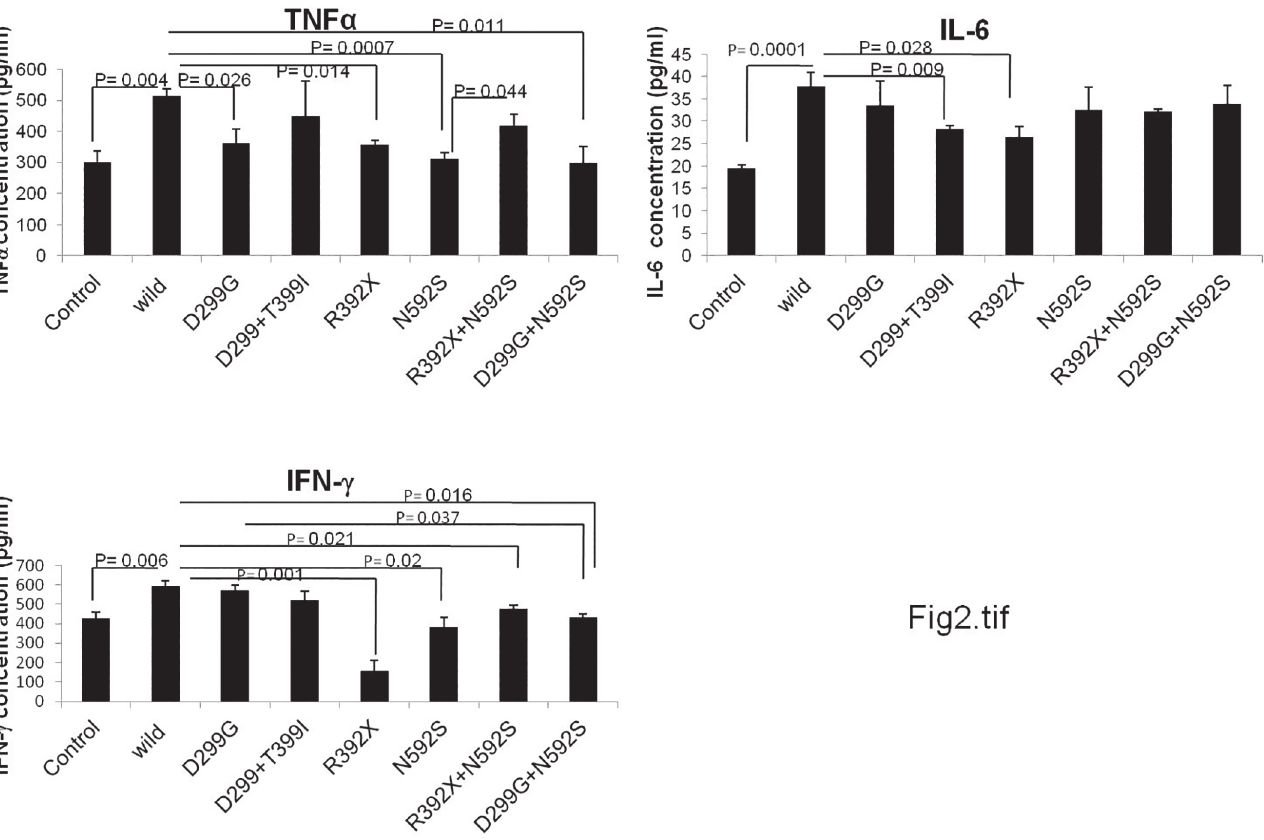
Fig 2. Analysis of cytokines level in UC patients and controls. TNF α , IL-6 and IFN γ levels were measured in human blood plasma samples (n = 4 – 8) by ELISA. Cytokines level were measured in wild type controls, and in wild type patients as well as with different genotype category of patient samples. The data is represented as mean value of 4 – 8 samples in each group. The significance level of α (cid:1) 0.05 was chosen for all sets. pg = picograms, ml =